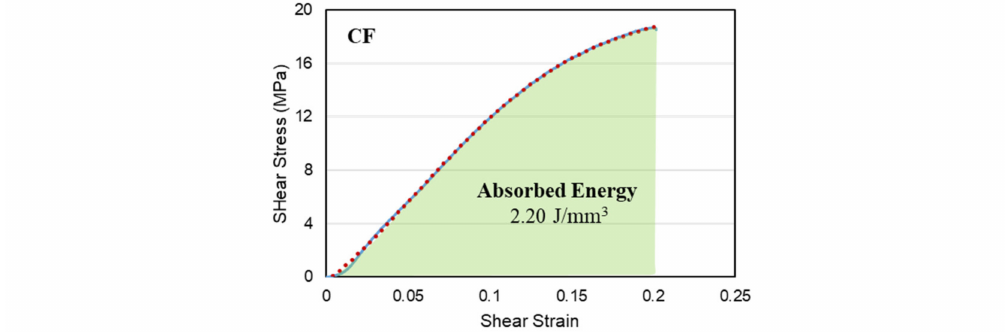
Figure 13. Energy absorption value based on the average stress-strain result of lattice structures.